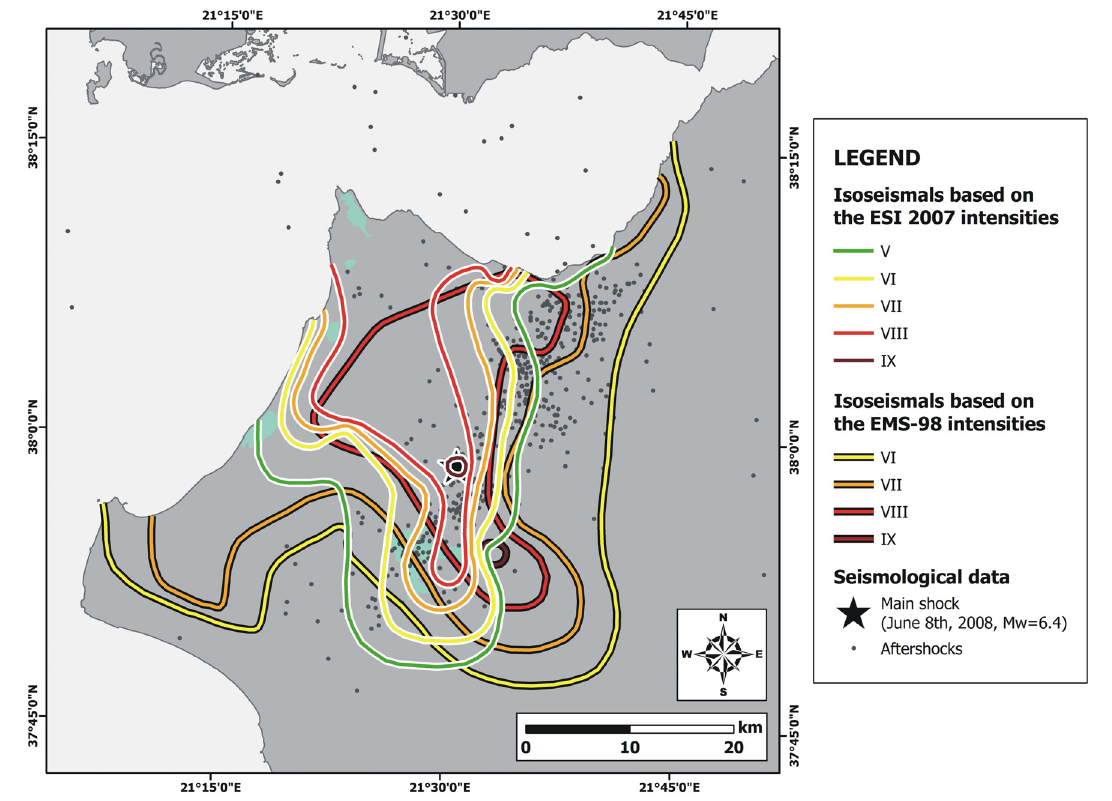
Figure 7. Comparison, similarities and differences between ESI 2007 and EMS-98 intensities and isoseismals for the 2008 Andravida